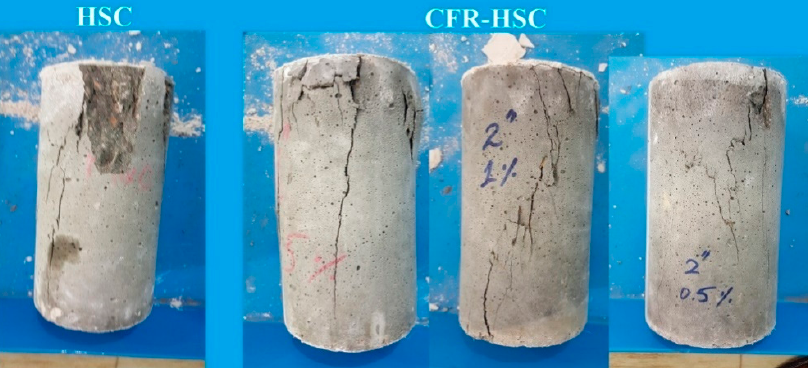
Figure 5. HSC and CFR-HSC specimens after compressive strength tests .